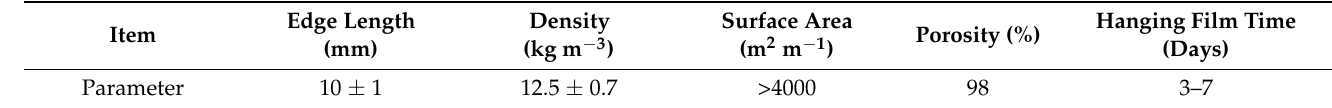
Table 1. The characteristics of PPC.